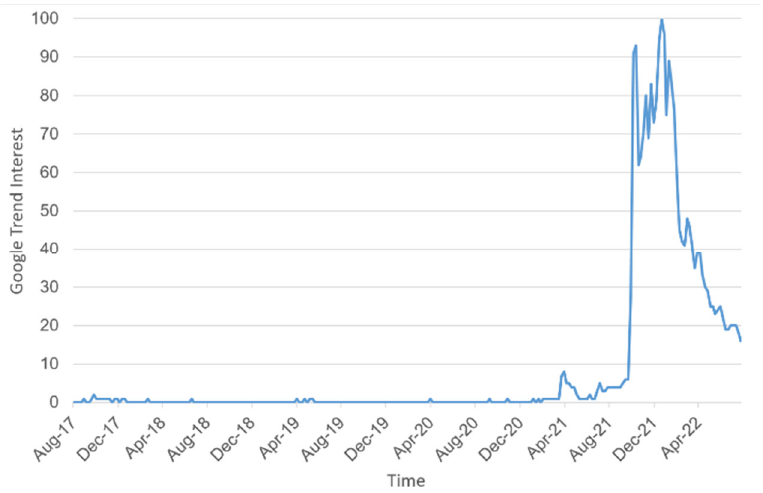
Figure 1. Search volume for “Metaverse” over time (own diagram based on data from Google Trends retrieved 18 August 2022).